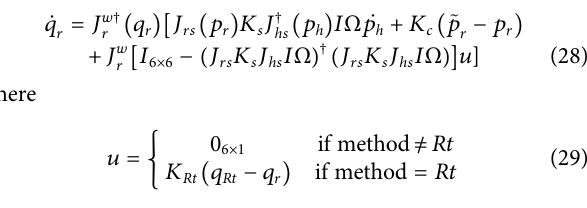
Figure 6 . A projection into the null-space of mapping